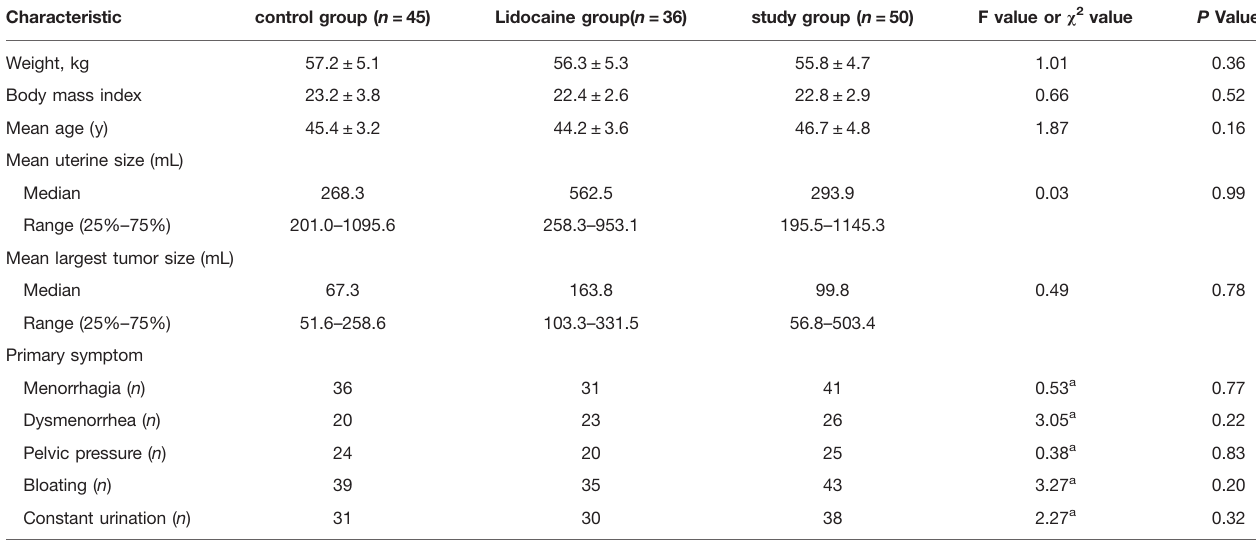
TABLE 1 | Comparison of baseline characteristics of clinical data between control group and study group in patients with uterine artery embolism.